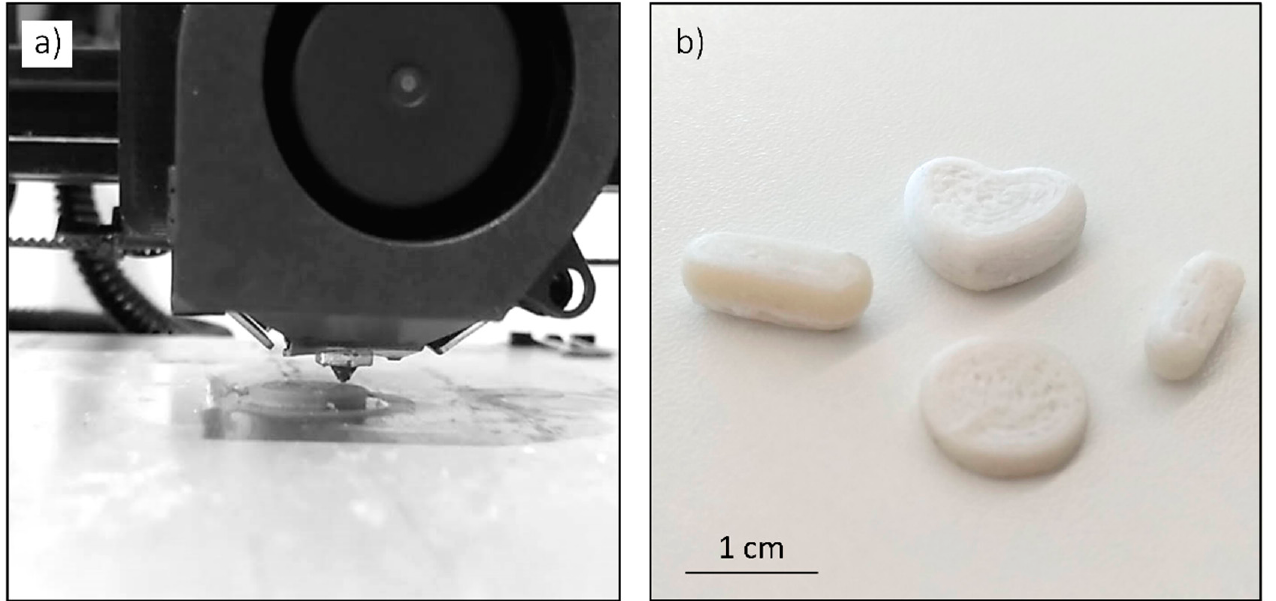
Figure 6. Detail of the 3D printer head printing a 3DP pill ( a ) and some examples of printed pills with different geometries and sizes ( b ).